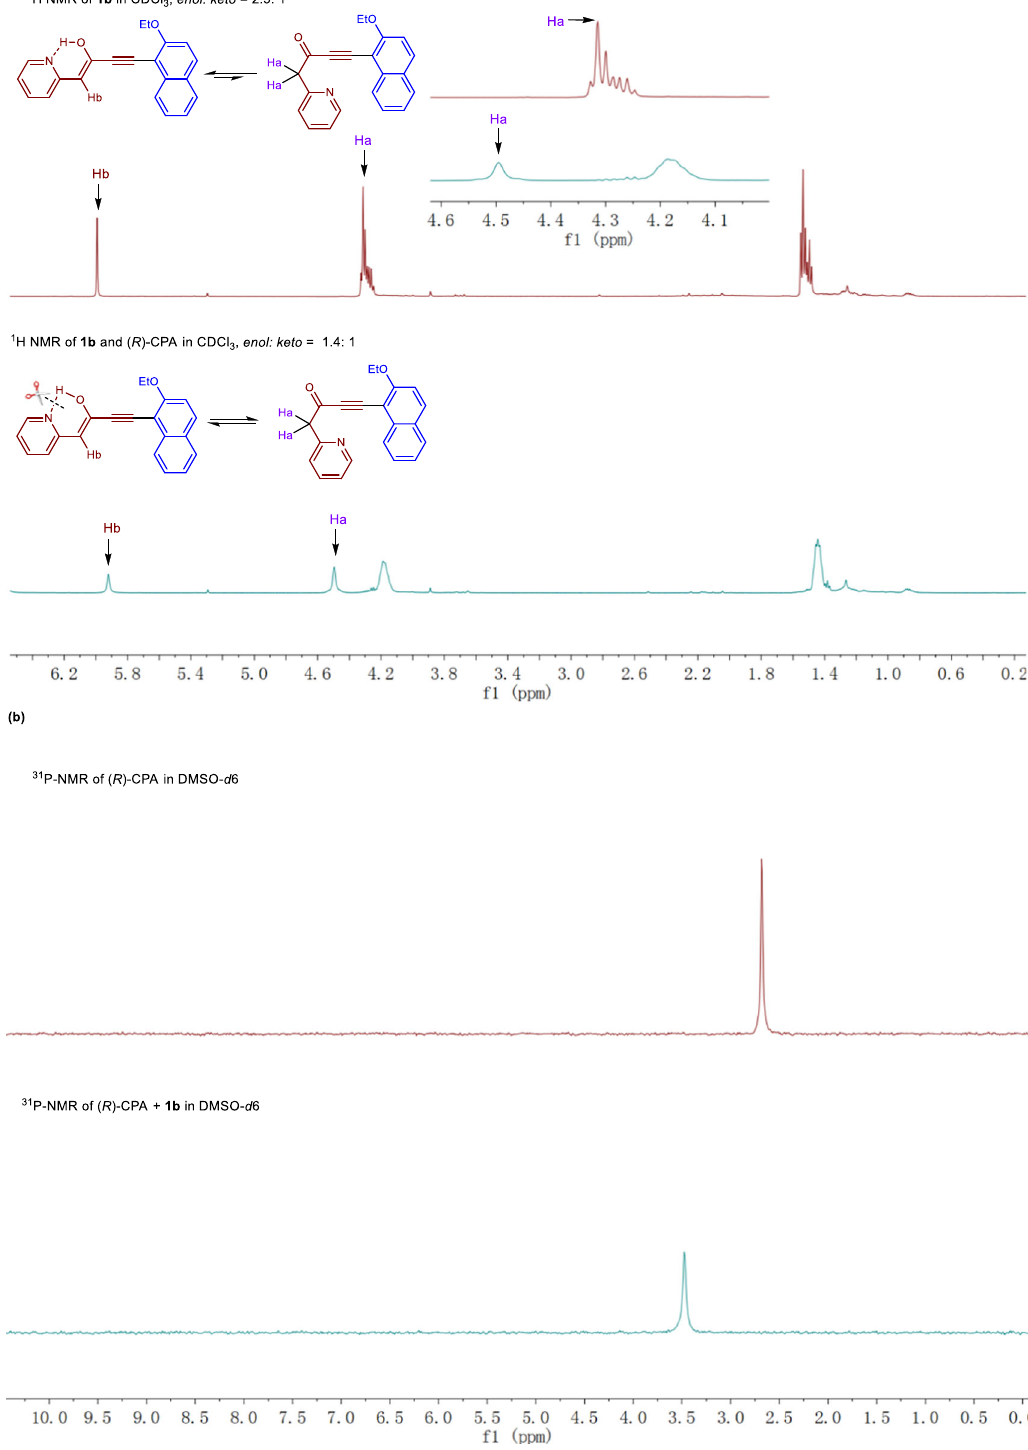
Fig. 5 Mechanistic studies of the reactivity of the cycloisomerization. a 1 H NMR studies of a mixture of 1b and ( R )-CPA. b 31 P NMR studies of mixture of 1b and ( R